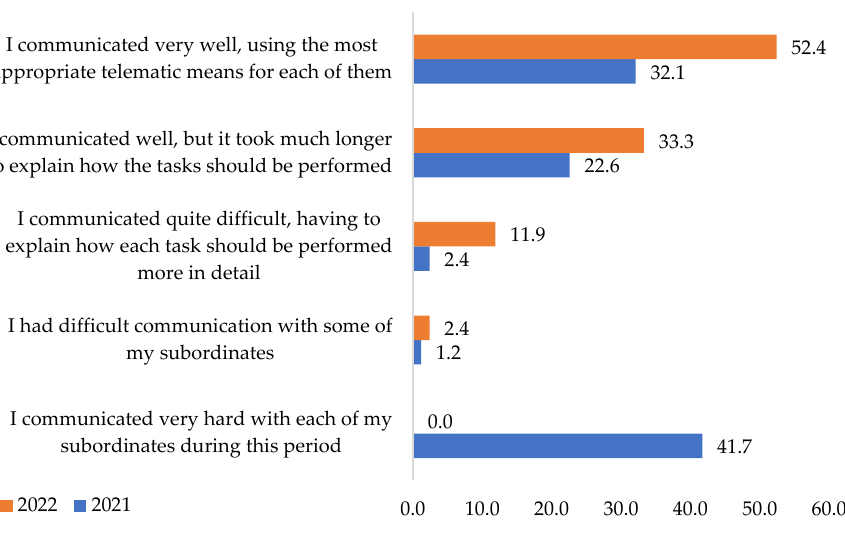
Figure 10. Leaders and staff communicating attitude: Data from field quizzes, 2021, 2022.